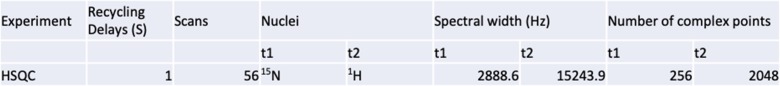
Parameters for HSQC NMR experiment.